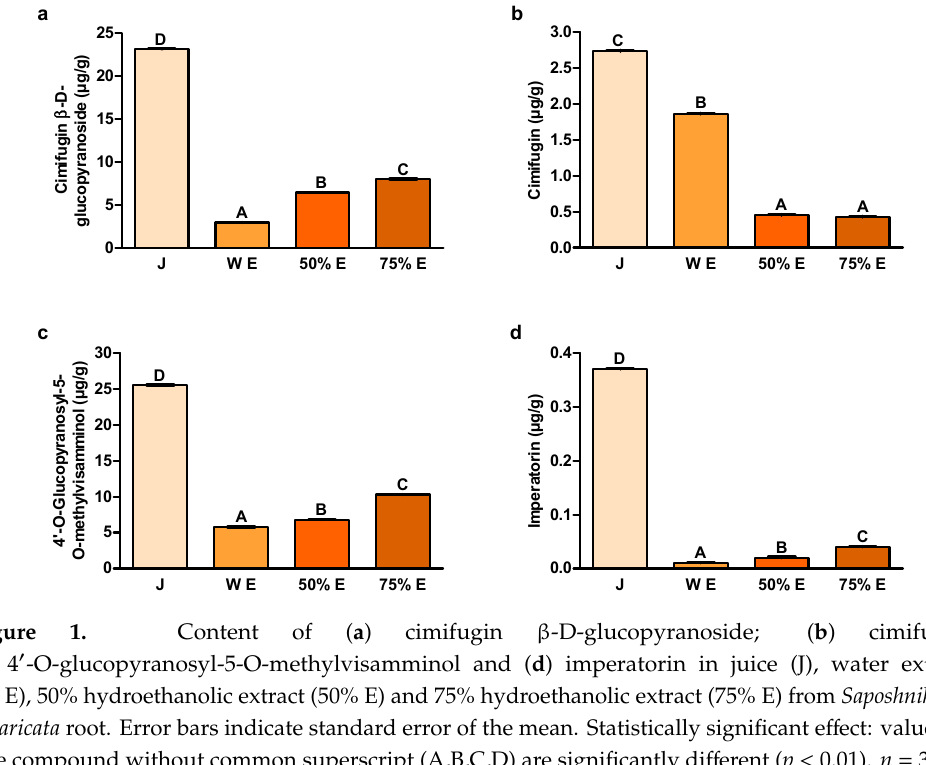
Figure 1. Content of ( a ) cimifugin β -D-glucopyranoside; ( b ) cimifugin; ( c ) 4 ′ -O-glucopyranosyl-5-O-methylvisamminol and ( d ) imperatorin in juice (J), water extract (W E), 50% hydroethanolic extract (50% E) and 75% hydroethanolic extract (75% E) from Saposhnikovia divaricata root. Error bars indicate standard error of the mean. Statistically significant e ff ect: values of one compound without common superscript (A,B,C,D) are significantly di ff erent ( p < 0.01). n =